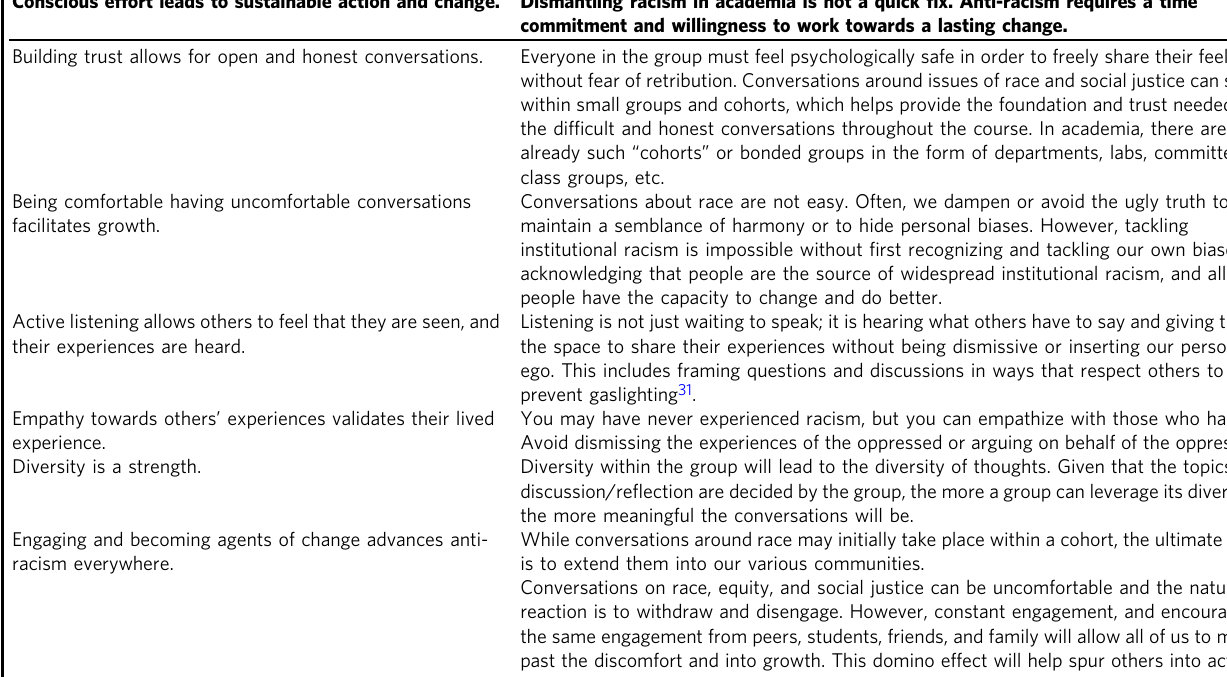
Table 2 Guiding principles for having productive, long-term conversations around issues of race and social justice in academia. Conscious effort leads to sustainable action and change. Dismantling racism in academia is not a quick fi x. Anti-racism requires a time commitment and willingness to work towards a lasting change. Building trust allows for open and honest